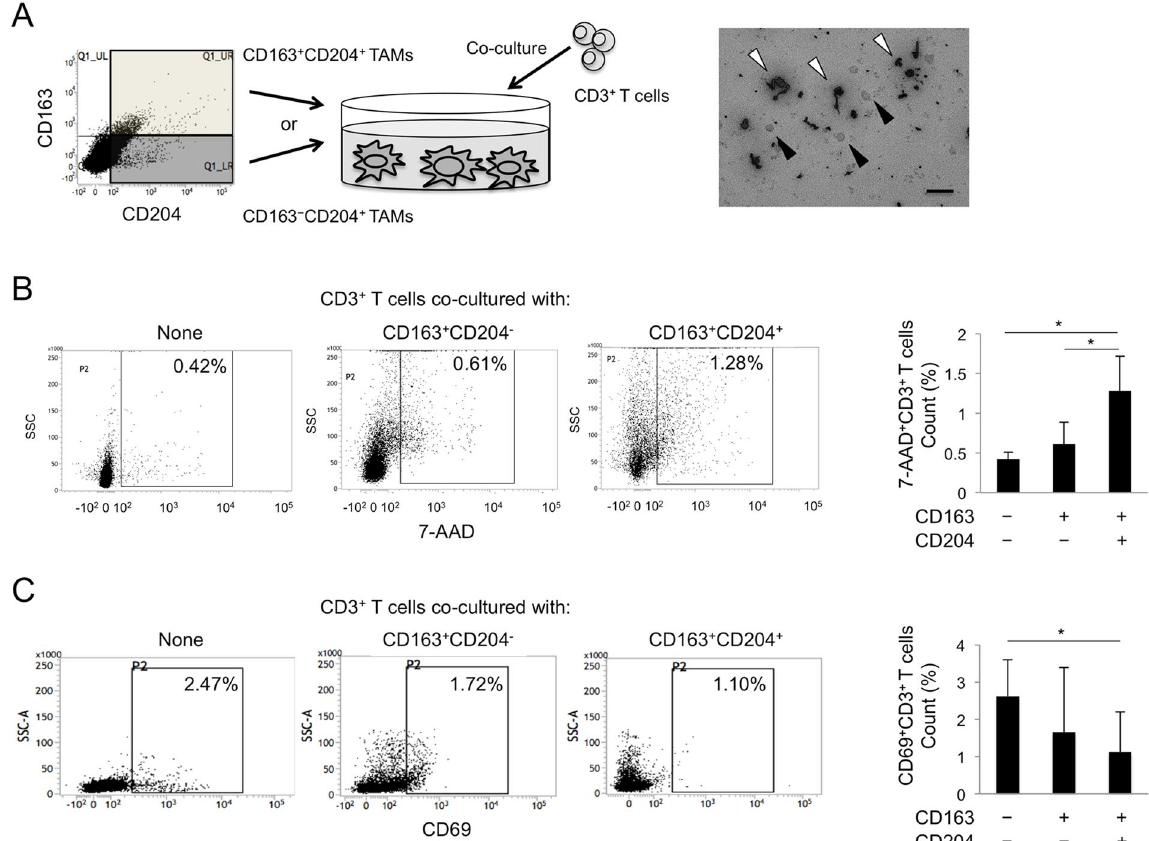
Figure 5. T cell regulation and apoptosis by co-culture with TAM subsets. ( A ) Scheme and representative image for the co-culture of TAM subsets (white arrowhead) and CD3 + T cells (black arrowhead) for 5 days. The detailed methods for cultivating cells are described in the Materials and methods section. Scale bars, 10 μ m. ( B ) The population of 7-AAD + CD3 + T cells co-cultured with TAM subsets from a representative OSCC patient. The number of 7-AAD + CD3 + T cells co-cultured with TAM subsets was analyzed using flow cytometry (n = 3 for each subset). Statistically significant differences between groups were determined by Wilcoxon signed-rank test ( * P < 0.05). ( C ) The population of CD69 + CD3 + T cells co-cultured with TAM subsets from a representative OSCC patient. The number of CD69 + CD3 + T cells co-cultured with TAM subsets was analyzed using flow cytometry (n = 3 for each subset). Statistically significant differences between groups were determined by Wilcoxon signed-rank test ( * P <